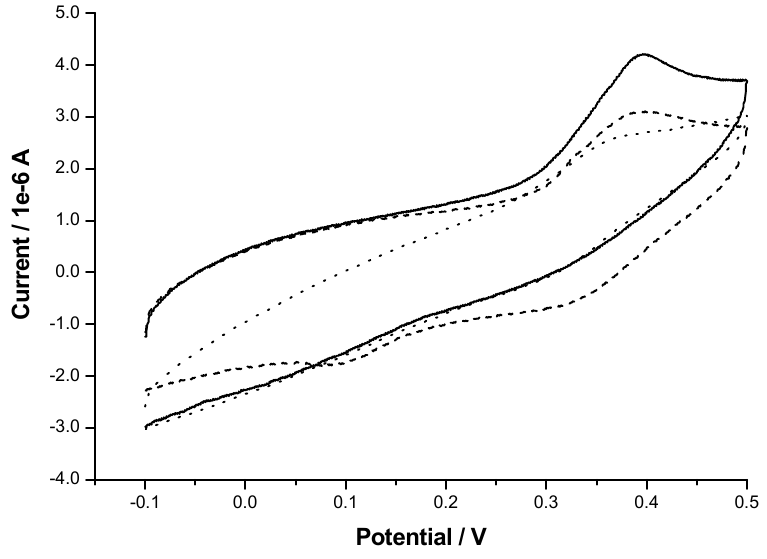
Figure 2. Cyclic voltammograms of 0.4 mM FcPF in 0.01 M TE buffer pH=8.0 at bare (dotted line), 6 ssDNA-modified (dashed line) and dsDNA-modified (solid line) glassy carbon electrode, scanned between -0.1 V and 0.5 V ( vs . Ag/AgCl), at 50 mV s -1